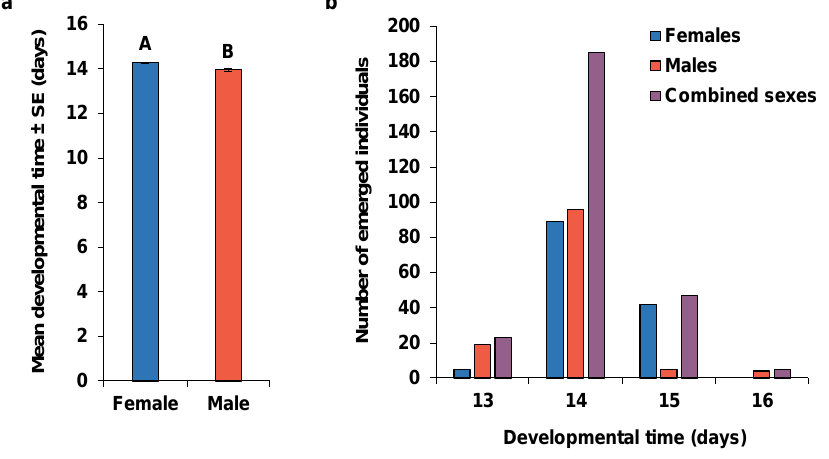
Figure 1. ( a ) The mean ( ± SE) developmental times of the two sexes. Bars accompanied by different letters are significantly different (Wilcoxon-Mann-Whitney test, P < 0.0001). ( b ) Distribution of developmental times in Ooencyrtus lucidus females (n = 136), males (n = 124), and combined sexes (n =